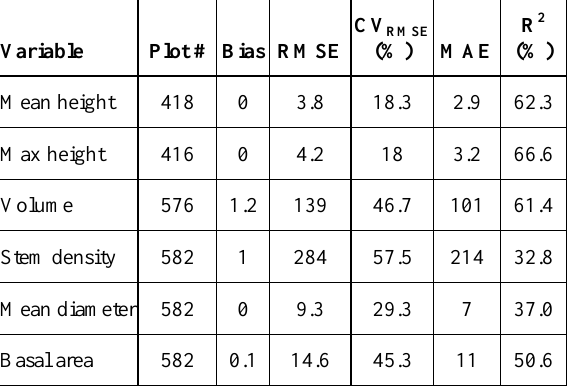
Table 3. Global accuracy statistics of prediction models